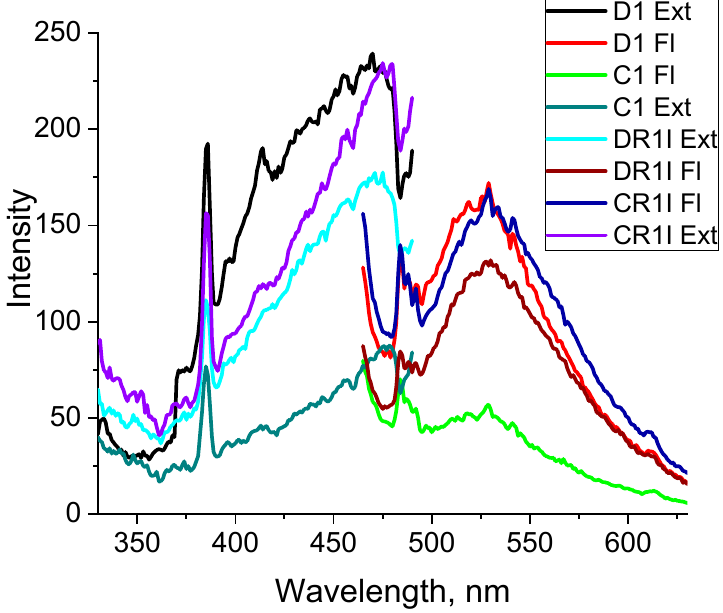
Figure 7. Excitation and fluorescence spectra of textile samples D1, C1, DR1I, and CR1I.